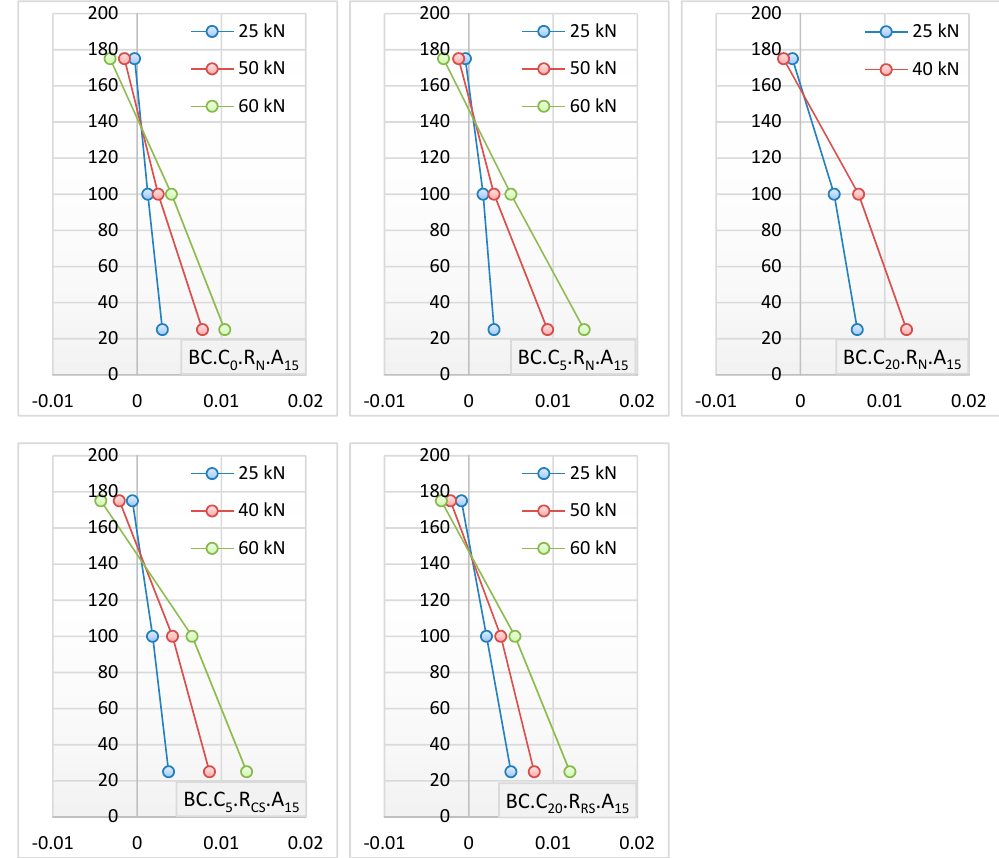
Figure 8. Concrete strain for specimens in Group A.